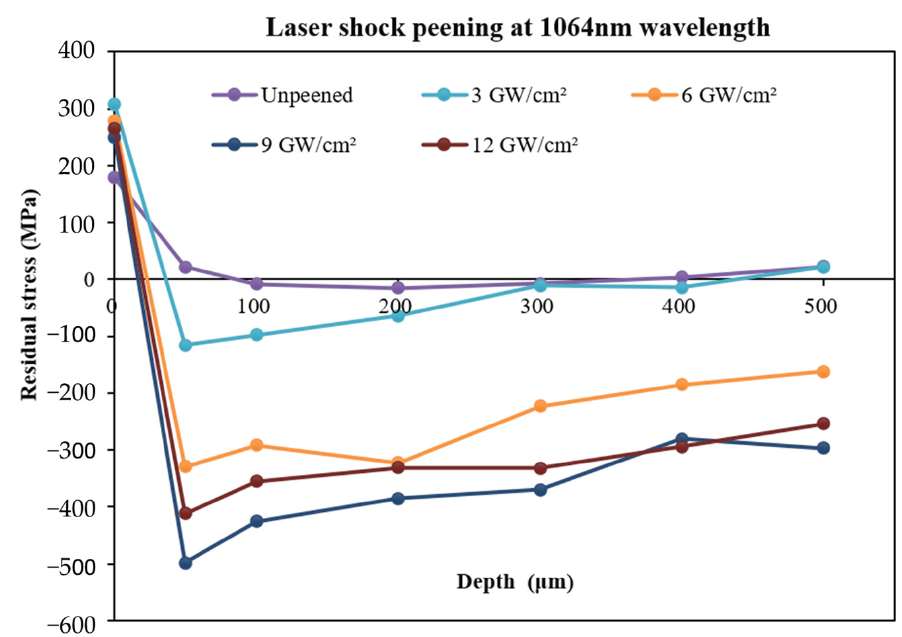
Figure 2. Residual stress distribution of LSPwC samples at 1064 nm wavelength.